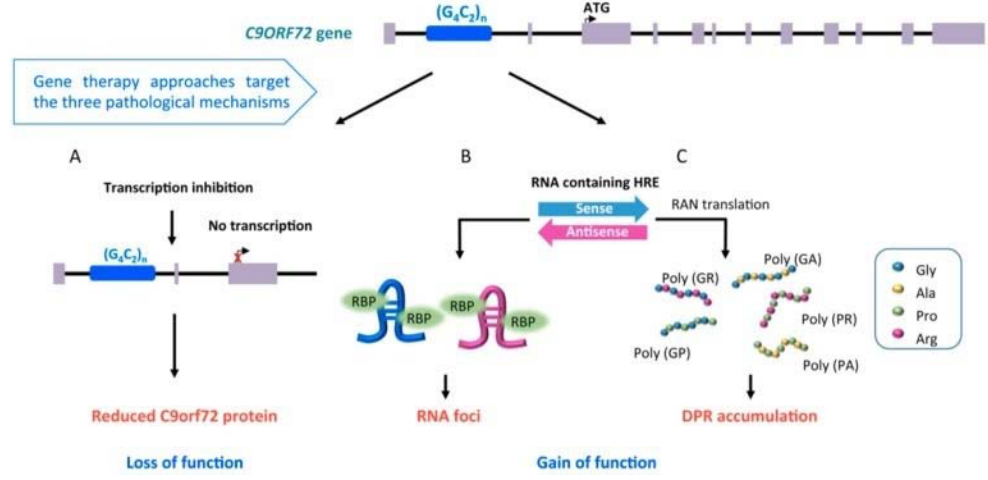
Figure 1. Pathological mechanisms involved in C9orf72 -ALS: ( A ) transcription inhibition (loss of function); ( B ) detection of RNA foci, involved in impairment of RNA metabolism (gain of function); ( C ) accumulation of toxic dipeptide repeat proteins (DRP) aggregates (gain of function) (derived from